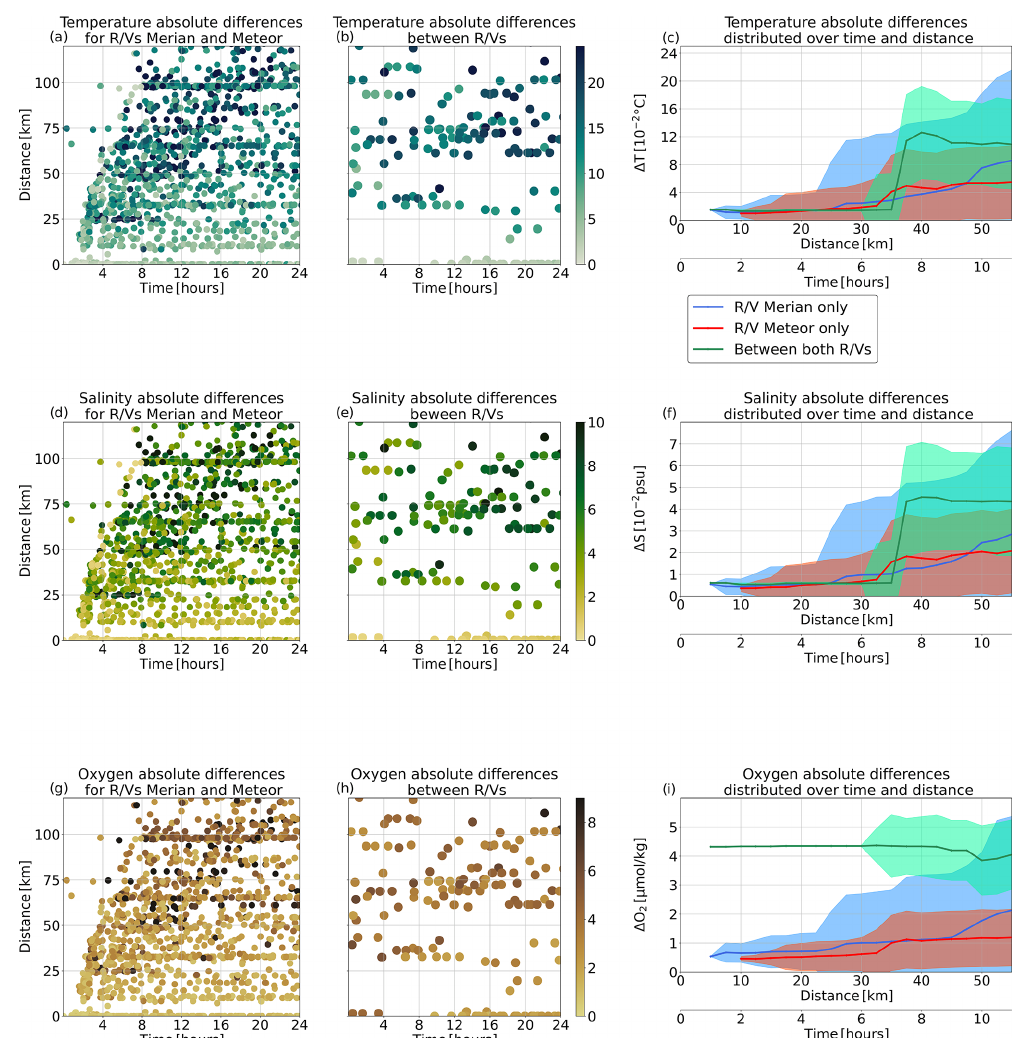
Figure 7. Same as Fig. 6 but for the comparison between R/Vs Maria S. Merian and Meteor .